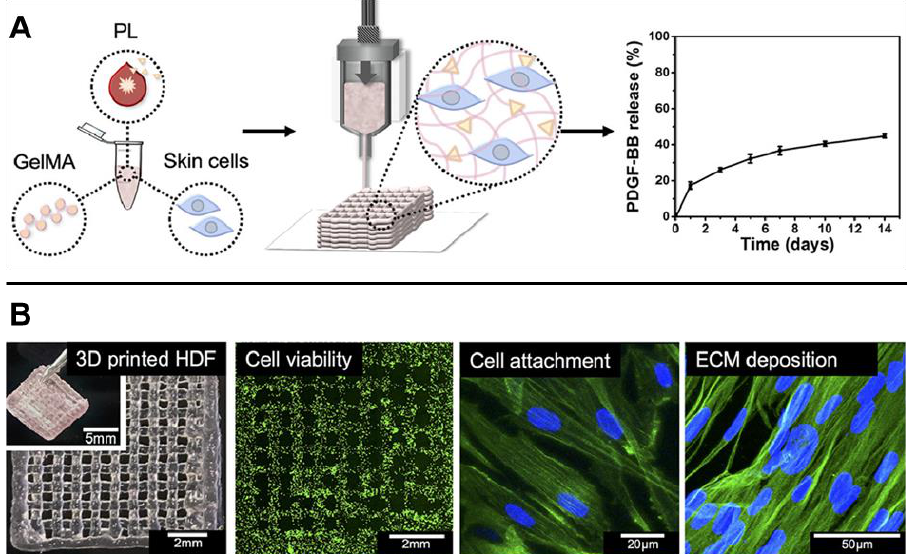
Figure 2. Gelatin methacrylate (GelMA) hydrogel with encapsulated platelet lysate (PL) and human dermal fibroblasts (HDFs) for acute wound healing. ( A ) Schematic of hydrogel bioprinting. Incorporation of PL resulted in sustained release of angiogenic PDGF-BB over 14 days. ( B ) 3D printed constructs were cytocompatible and promoted dermal cell attachment and matrix deposition. Adapted with permission from [38], 2021, Daikuara et al.